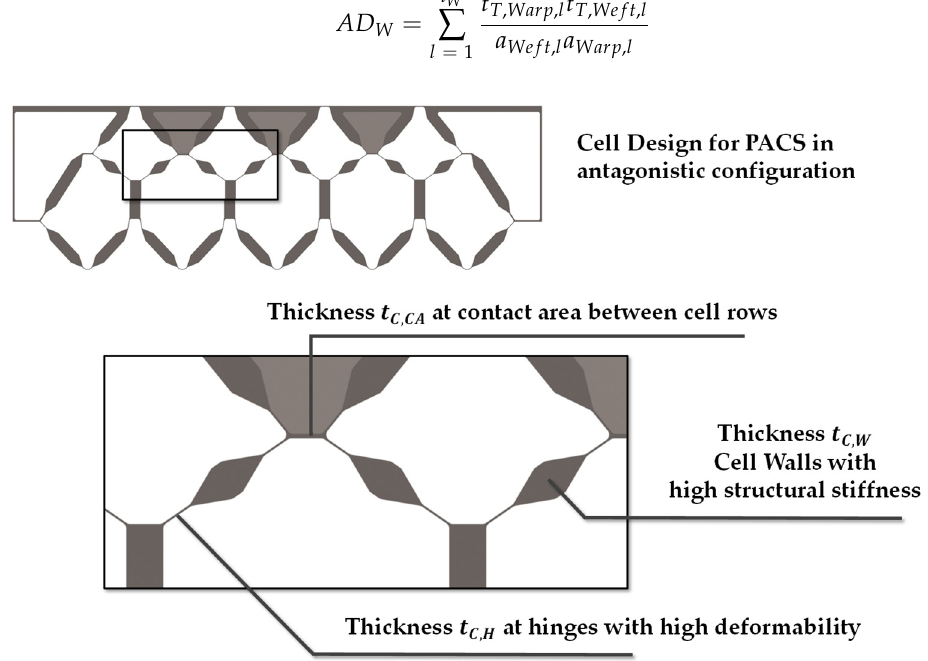
Figure 6. Cell design, geometrical characteristics, and thickness parameters.